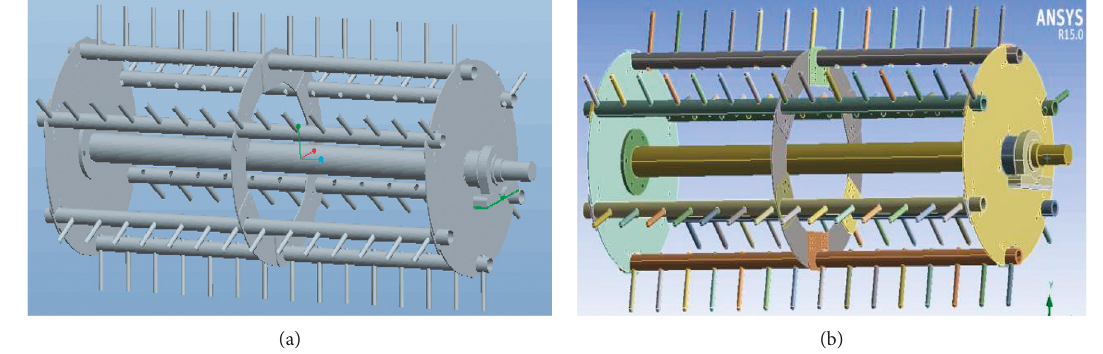
Figure 2: 3D model of cylinder II. (a) Finite element model. (b) Imported